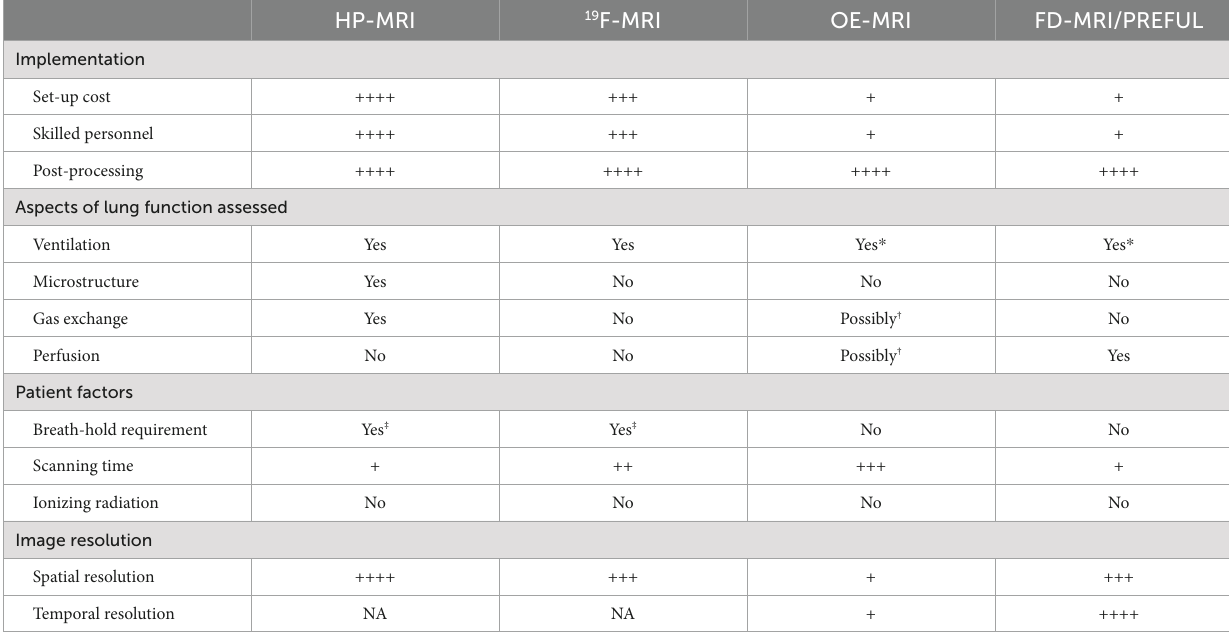
TABLE 2 Summary of the key differences between